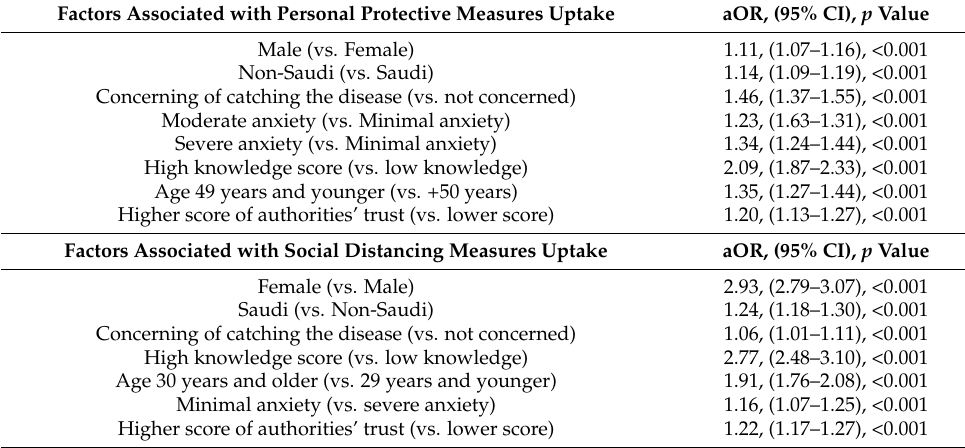
Table 8. Factors associated with preventive measures